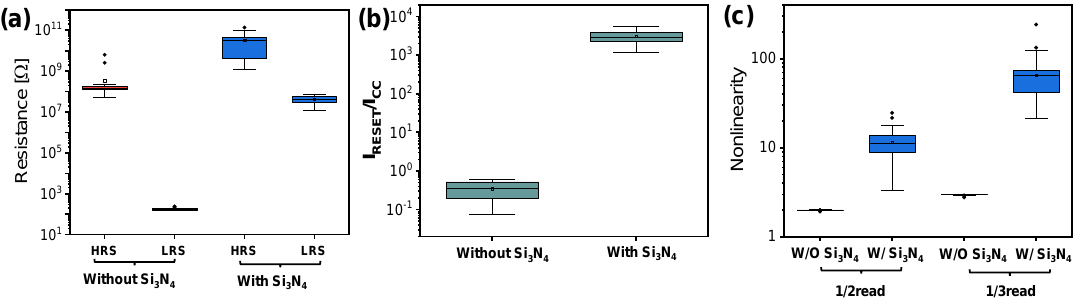
Figure 3. Statistical distributions of ( a ) high-resistance state (HRS) and low-resistance state (LRS) resistance, ( b ) I RESET / I CC , and ( c ) nonlinearity for Ni / HfO 2 / SiO 2 / Si and Ni / HfO 2 / Si 3 N 4 / SiO 2 / Si devices.